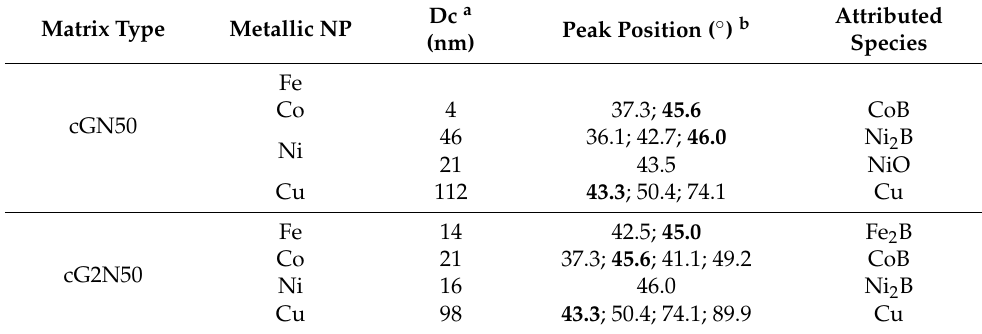
Table 6. Crystallographic parameters of the NPs obtained by PXRD of the cycled matrixes. Matrix